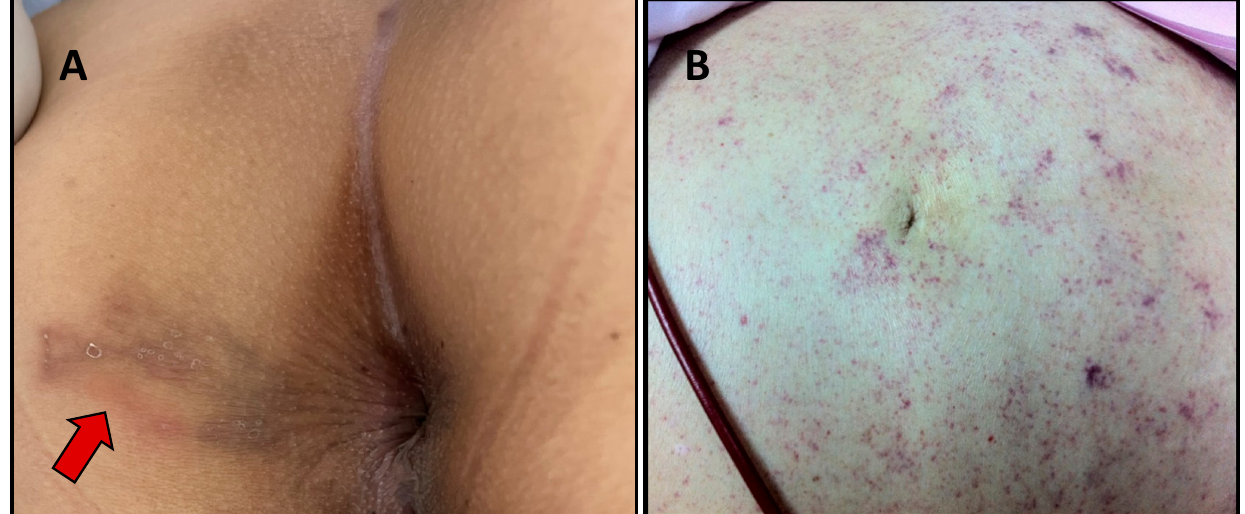
Figure 3. Skin lesions that can be found in strongyloidiasis. Larva currens in the perianal area (arrow) ( A ) and periumbilical parasitic thumbprint purpura in a patient with disseminated strongyloidiasis ( B ). Picture ( A ) courtesy of Than Narkwiboonwong.